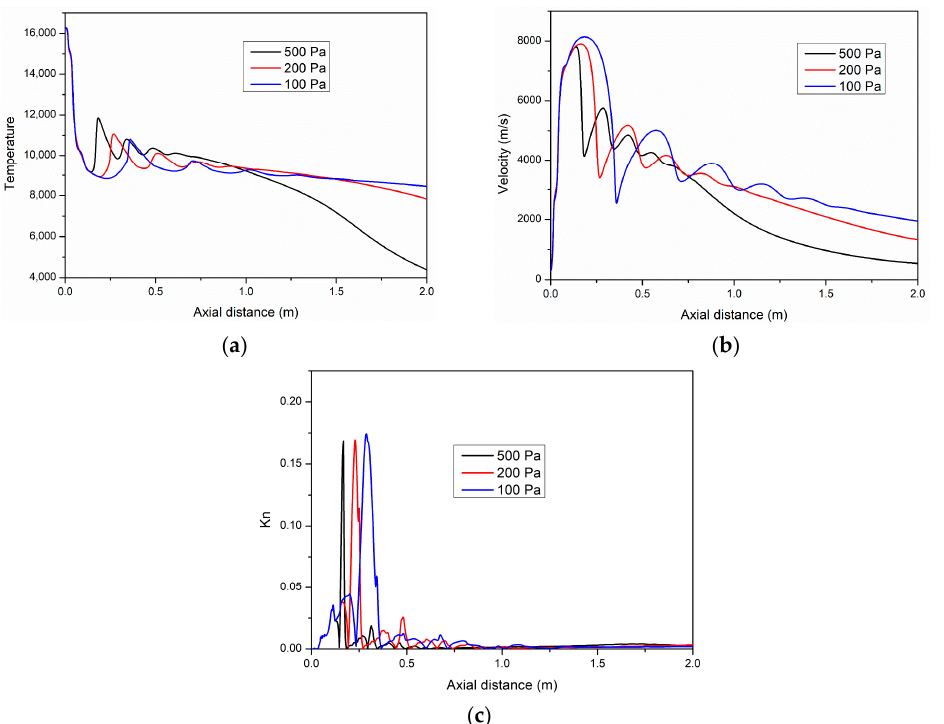
Figure 10. Variation of the 60Ar–30He plasma jet ( a ) temperature, ( b ) velocity, and ( c ) Knudsen number along the torch axis for different chamber pressures at a power input of 60 kW.